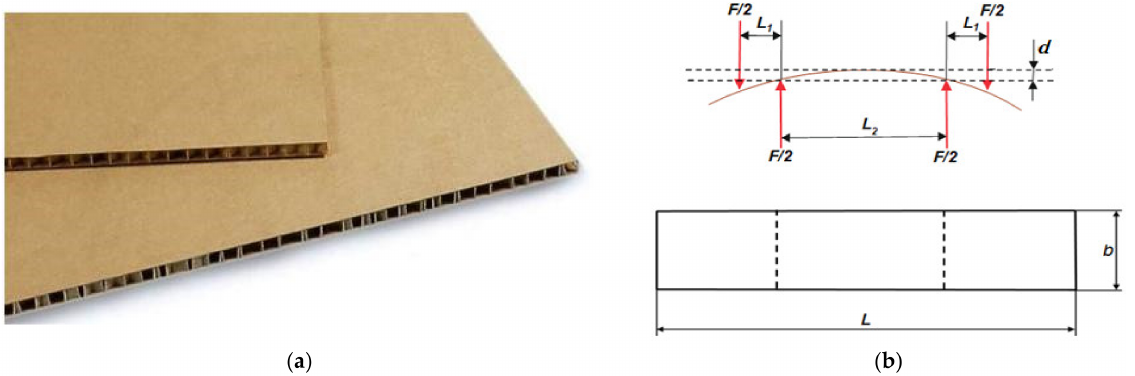
Figure 3. View of paperboard panel component ( a ) and scheme of support with dimensions of sample ( b